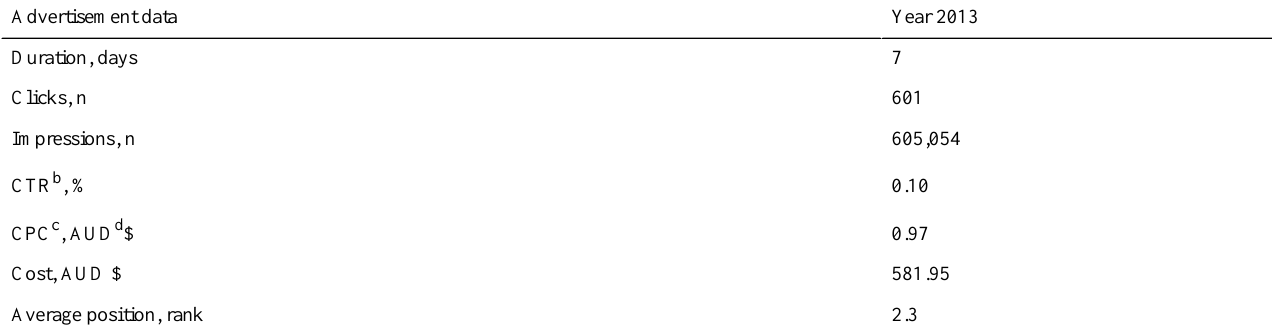
Table 5. Google TXT2BFiT advertisement data for top-of-page and side-advertisement text over 7 days in 2013 a